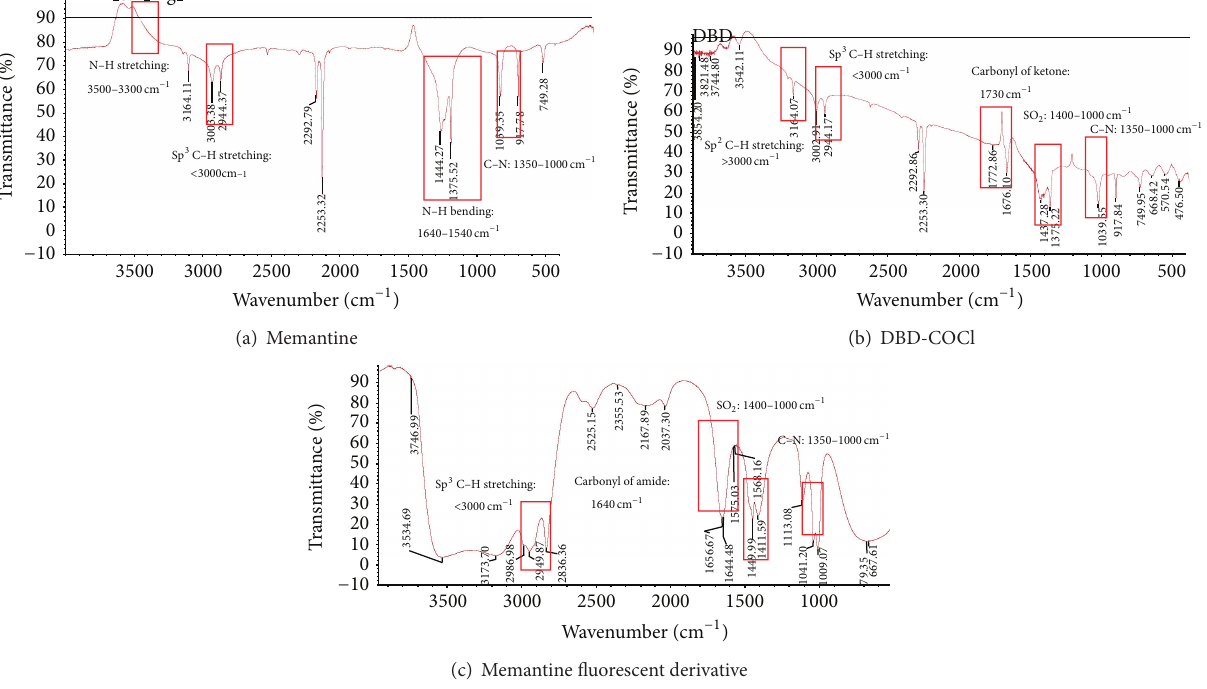
fraction was performed by IR and results are in Table 1 and Figure 5. The main difference among memantine, DBD- COCl, and the fluorescent derivative was the occurrence of the carbonyl amide at a wavenumber of 1644 cm −1 indicating the amide bond of the derivative. Figure 6 compares chromatograms of the memantine fluorescent derivative, underivatized memantine, mobile phase, and DBD-COCl. Under the reversed phase-HPLC, the derivative was eluted as a symmetric peak at 4.50 min and was well separated from DBD-COCl, which co-eluted as a solvent front. No interferences from the excess DBD-COCl, underivatized memantine, or mobile phase were observed. The method is selective for the fluorescent